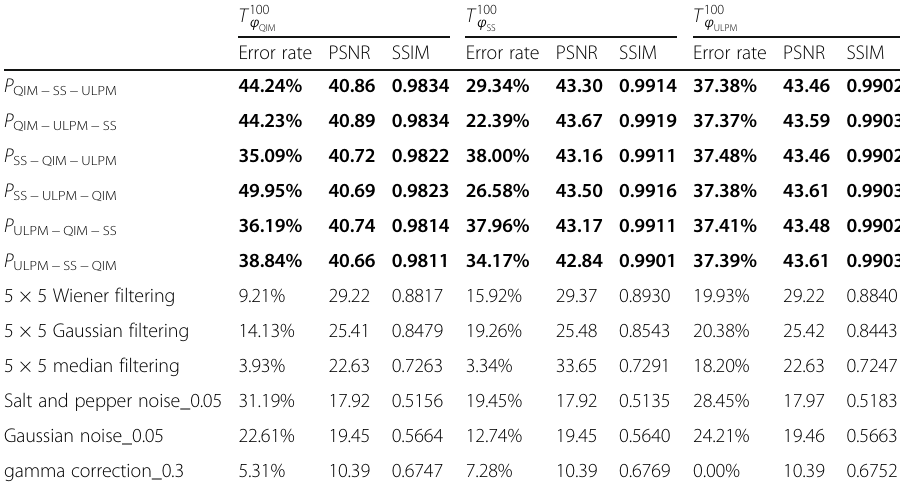
Table 2 Comparisons of Wiener filtering, Gaussian filtering, median filtering, salt and pepper noise, Gaussian noise and gamma correction, and the proposed method in error rate and image quality for watermarked images with payload 100 bits